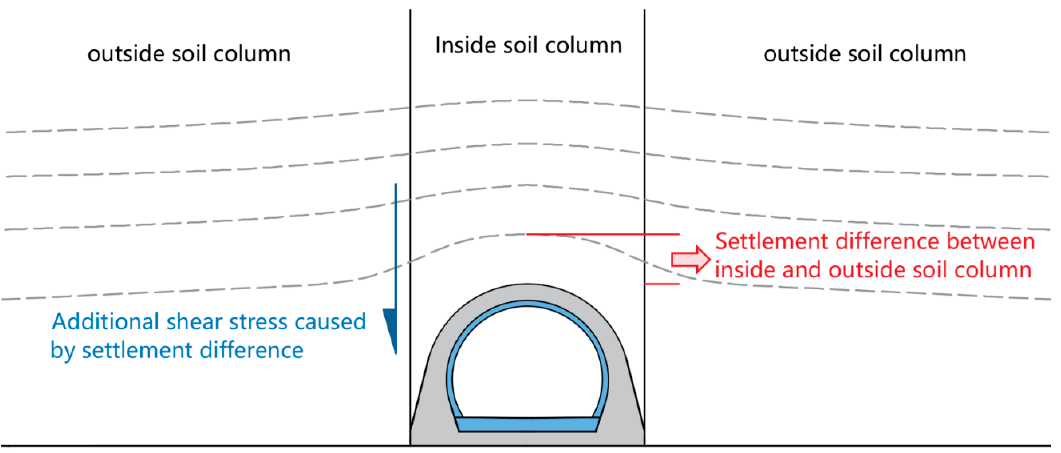
Figure 18. Additional shear stress caused by the settlement difference between inside and outside soil columns.